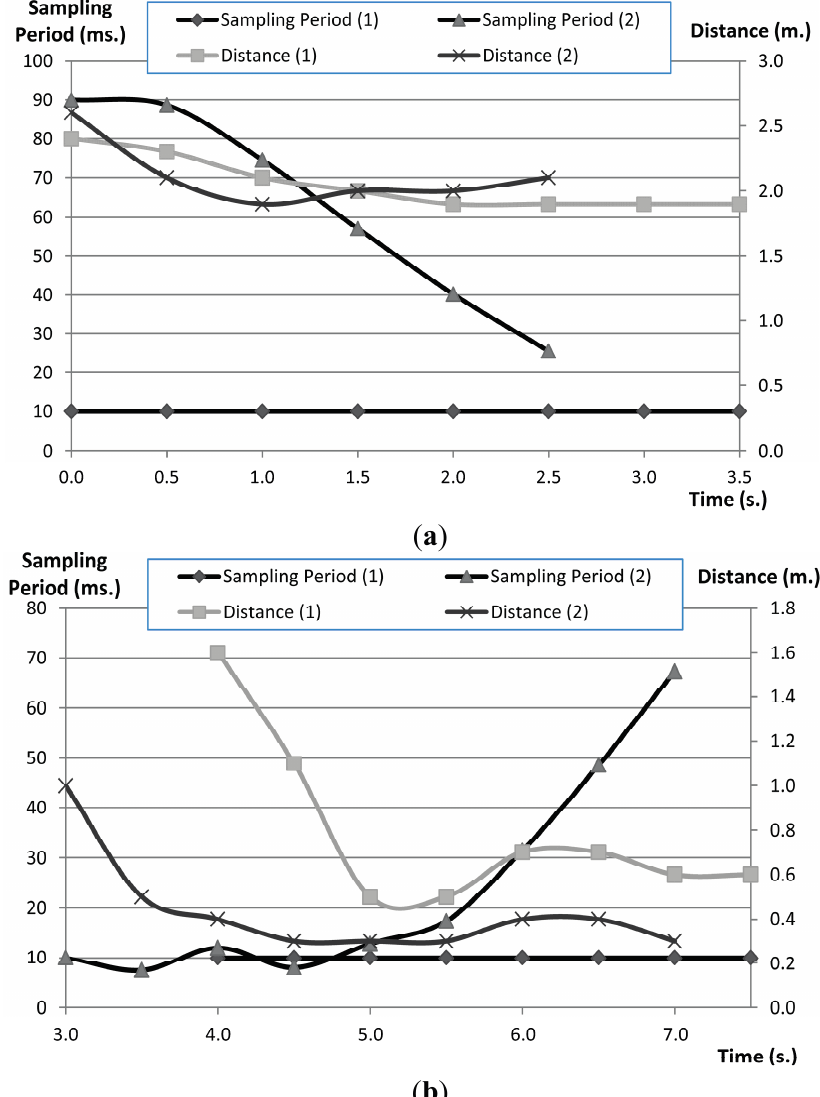
Figure 25. Sampling period and distance variations along time robot navigation, without the proposal ( a ) and using the proposal ( b ) for two different